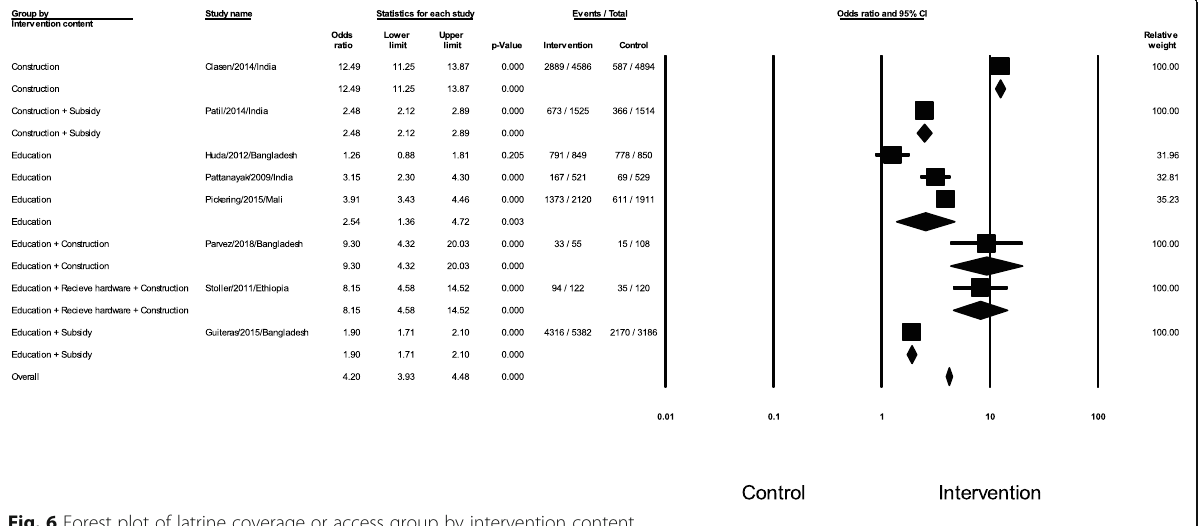
Fig. 6 Forest plot of latrine coverage or access group by intervention content